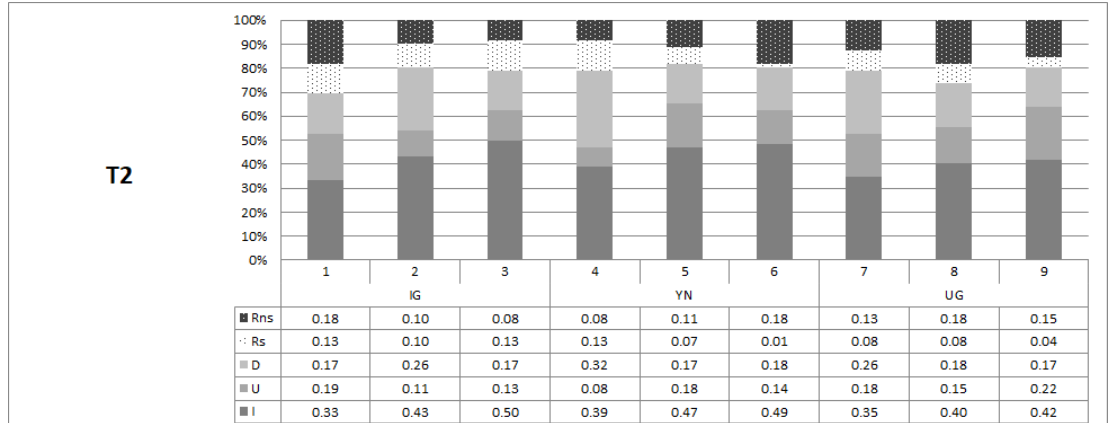
Figure 5. Distribution of types by period in treatment T2. Notes: Each cell entry report the share of choices based on the individual offer profile types: Reactive non-selfserving (Rns), Reactive selfserving (Rs), Adapting Downward (D), Adapting Upward (U), and Immune (I) in Treatment 2. On the individual level, we distinguish participants who are consistently either of the I - or R -type in all three rounds of a given game type. Always I -participants are 43 in IG (129 observations) respectively, 39 in YN (117 observations), and 24 in UG (72 observations) whereas always R -participants are 19 (57 observations) in IG, 22 in YN (66 observations), and 16 (48 observations) in UG (see Table 7). As expected, the average I -type offer is particularly low in IG ( 0.899 ) and increases when the game becomes more strategic, in the sense of possible sanctioning and (not) monitoring the offer in (YN, 3.103) UG (4.639). Reactive participants have a similar frequency in IG and UG; moreover, their initial offers are similar in the two game types (respectively 10.263 and 10.604). However, average offers are adjusted more in IG than in UG, both upward and